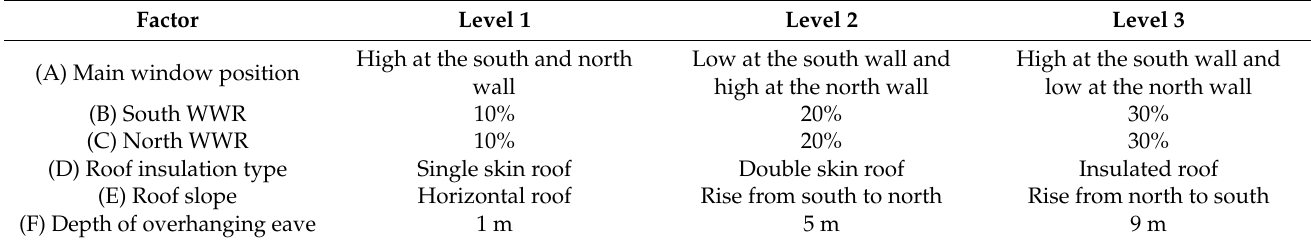
Table 4. Factors and corresponding levels of orthogonal